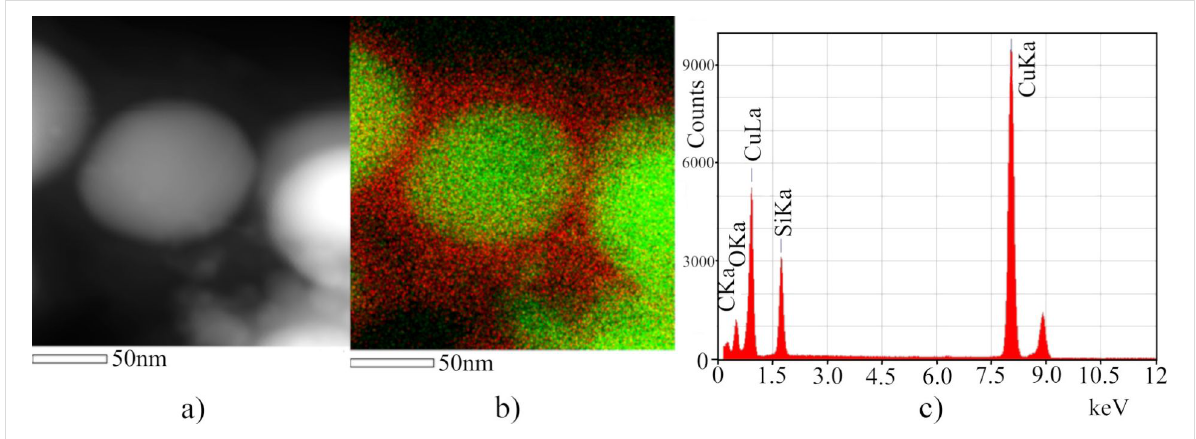
Figure 7: a) Scanning electron microscopy image of the obtained Cu@SiO x nanoparticles (1 < x < 2); b) elemental mapping, dark (red): silicon, light (green): copper; с ) EDX-spectrum.